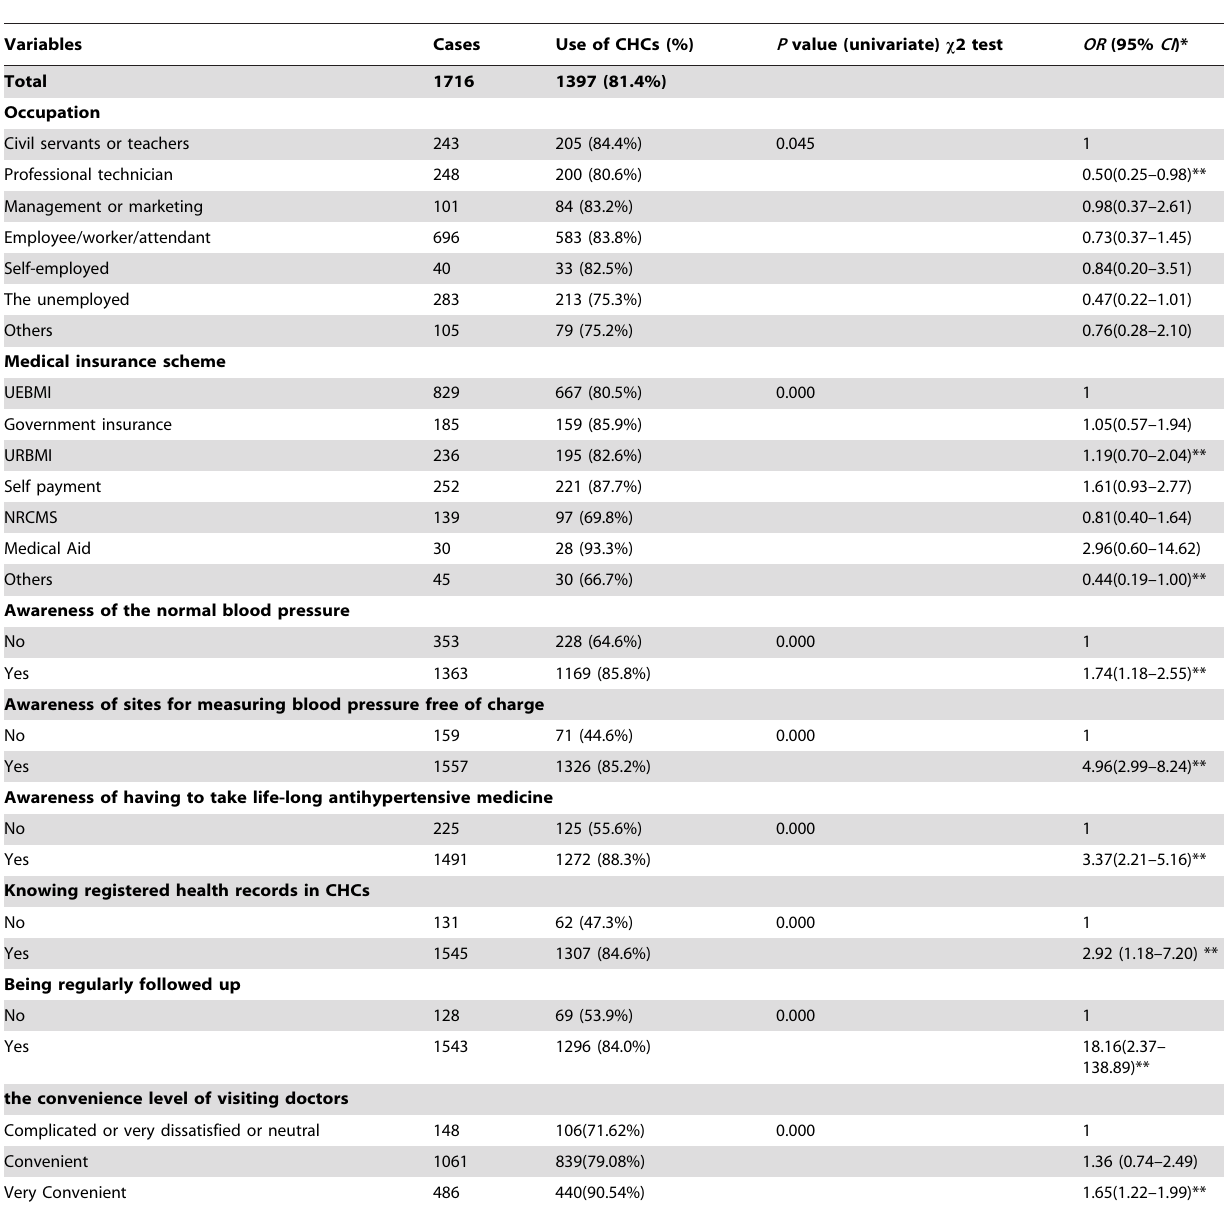
Table 2. Factors associated with the regular use of CHCs for the management of hypertension (This table shows the statistically significant results of univariate analyses and multiple logistic regression